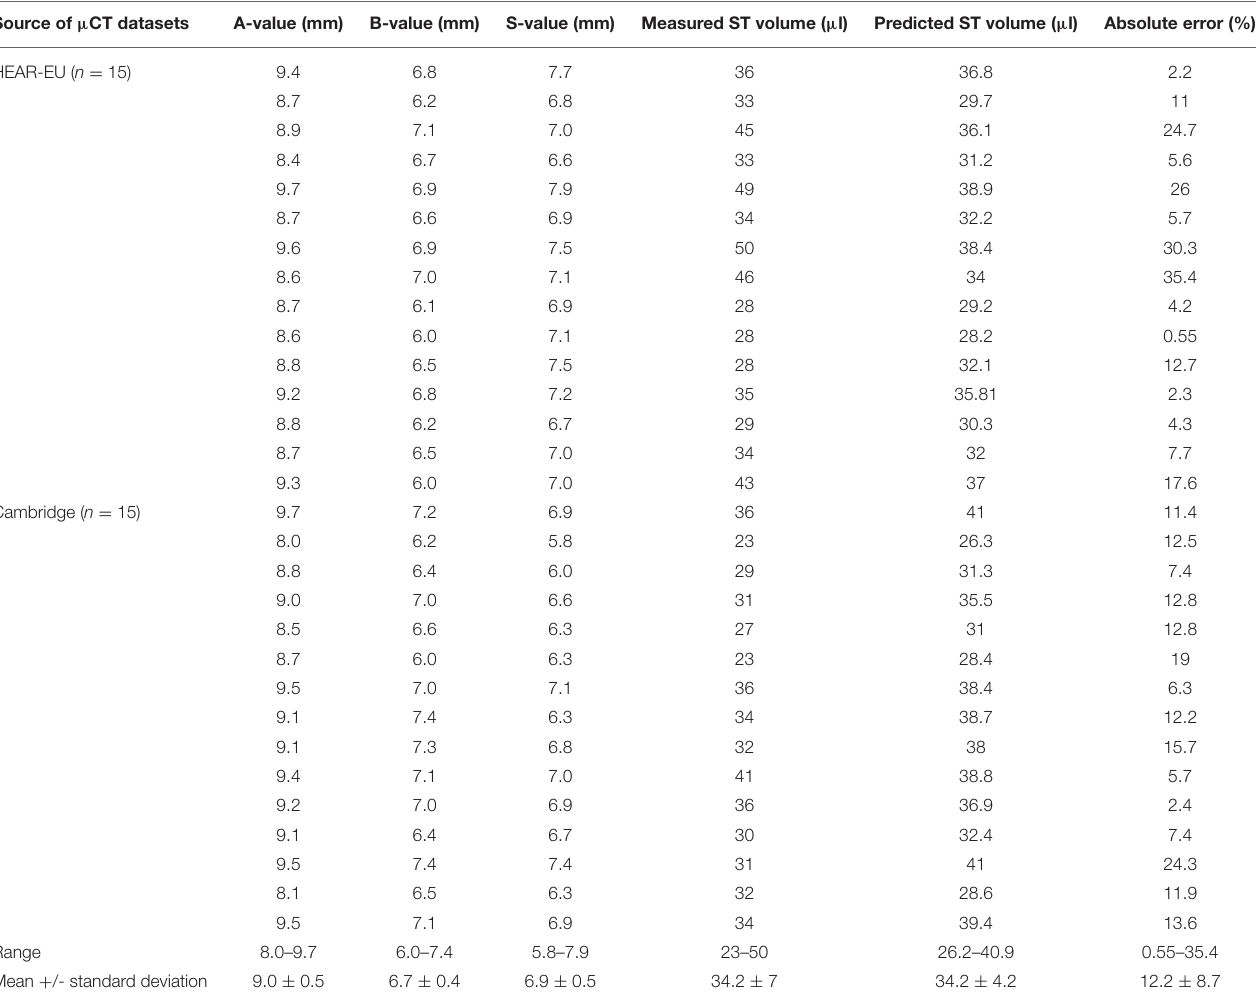
TABLE 1 | A-, B-, S-values measured from the µ CT images in the oblique coronal view of cochlear basal turn and ST volume measured from 3D segmented model of ST. Source of µ CT datasets HEAR-EU ( n =